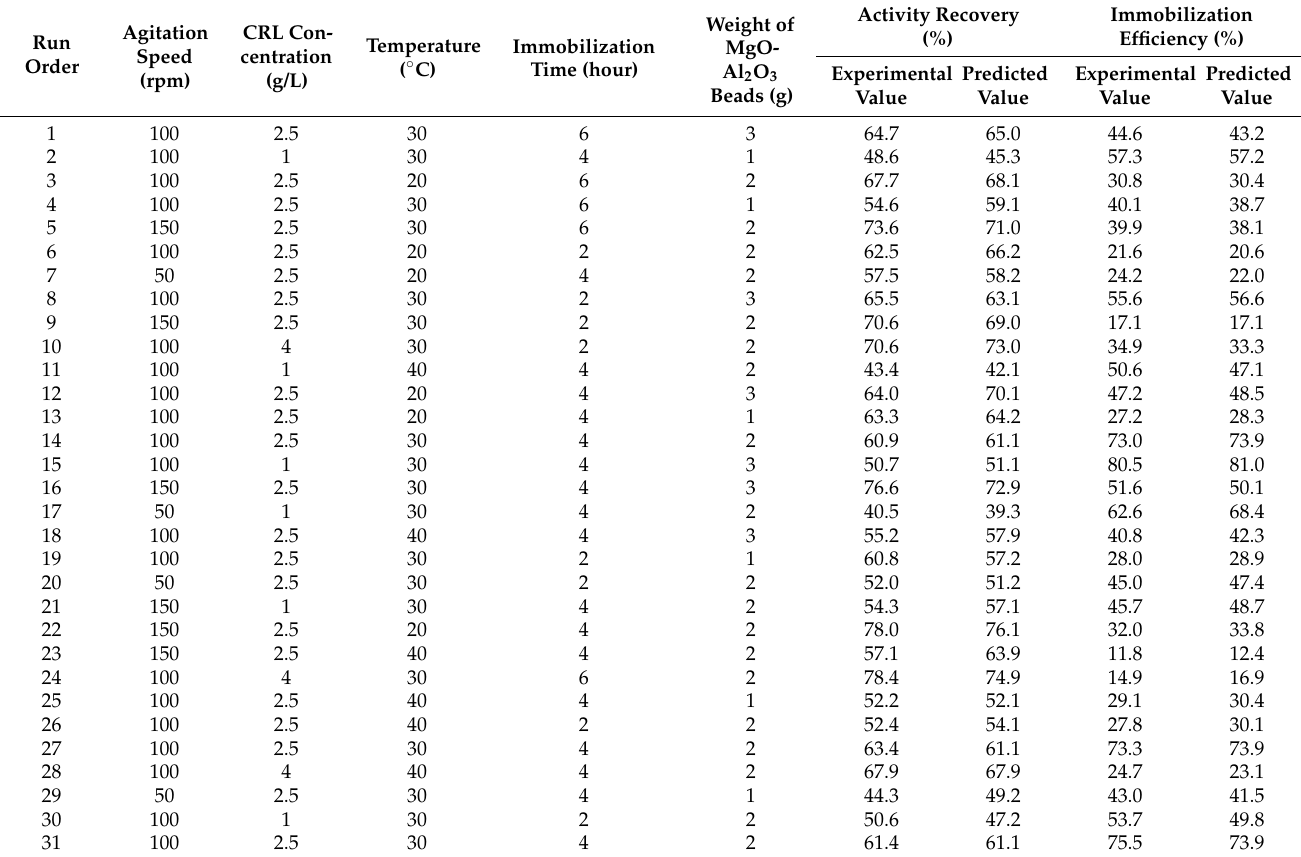
Table 1. Experimental design for response surface design for CRL immobilization on MgO-Al 2 O 3 using